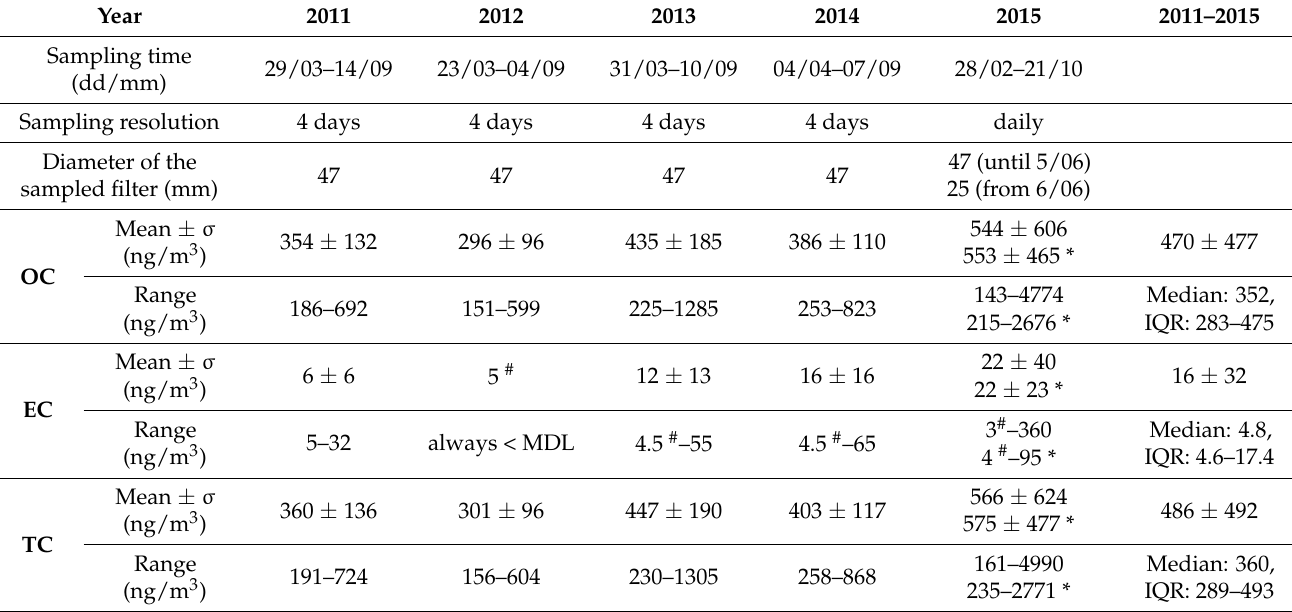
Table 2. Sampling data for the 2011–2015 campaigns; mean, standard deviation ( σ ), and range of the carbonaceous